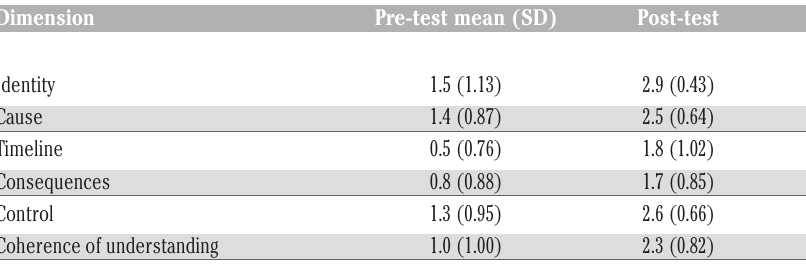
Table 2. Malaria knowledge test scores by self-regulation model (SRM) dimension (N=482, 3 items per SRM